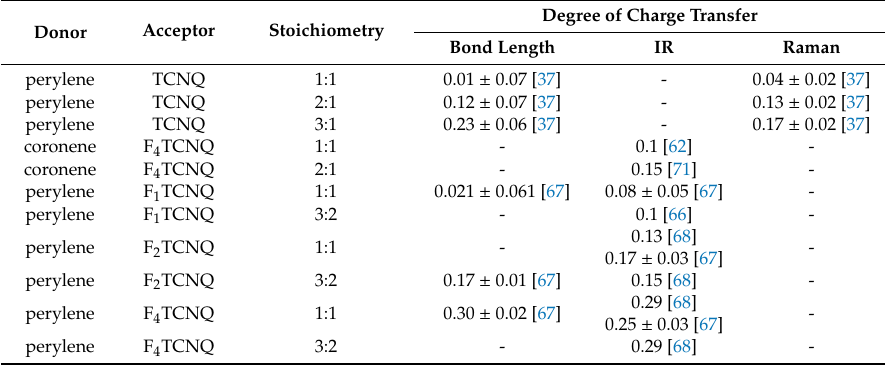
Table 2. The degree of charge transfer in some TCNQ and fluorinated TCNQ CTCs